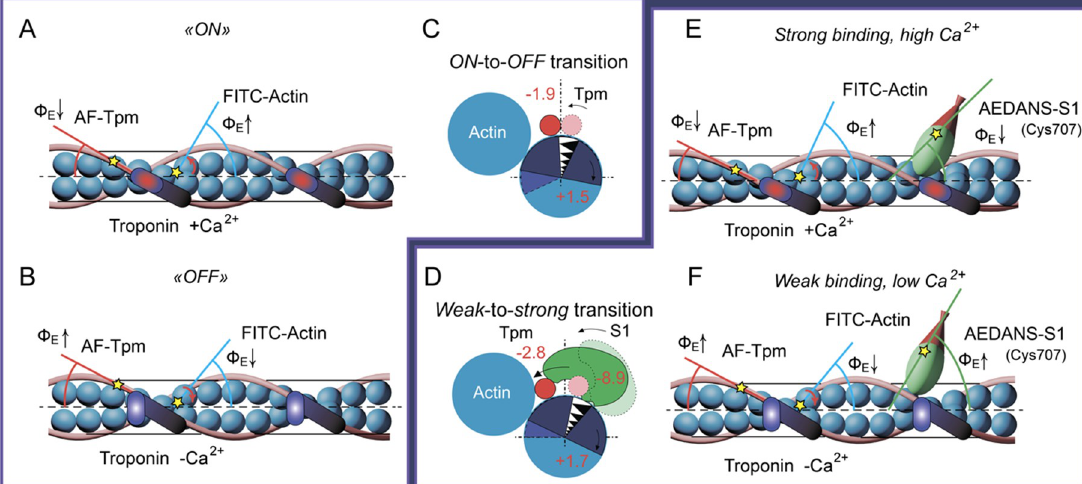
Figure 3. The presumed relationship between changes in the polarized fluorescence parameter Φ E and spatial rearrangements of the proteins in the complex F-actin–Tpm–TN at high ( A ) and low ( B ) Ca 2+ , and in the complex F-actin–Tpm–TN–S1 at simulation of strong ( E ) and weak ( F ) binding of S1 to F-actin. Fluorescent probes are denoted as yellow stars. ( C , D ) Changes in the Φ E values (in degrees) for FITC-actin, AF-Tpm, and AEDANS-S1 and corresponding spatial rearrangements of actin monomers, Tpm, and the myosin heads induced by transition between ON and OFF states of thin filament and between weak- and strong-binding states of S1 with